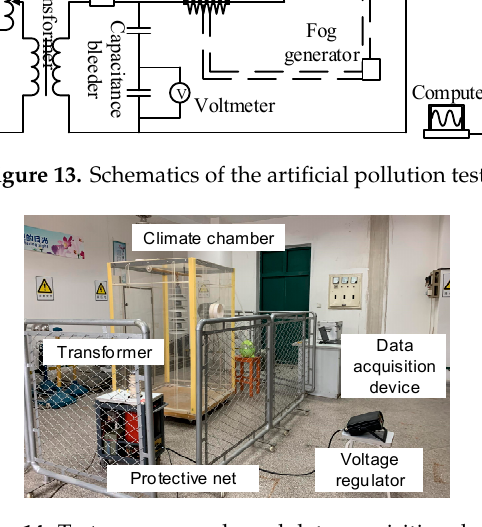
Figure 14. Test power supply and data acquisition device.